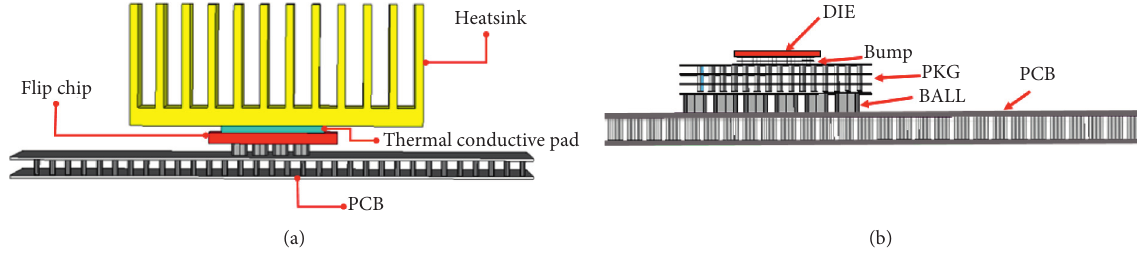
Figure 1: IC package: (a) simplified packaging model and (b) part of the packaging model without heatsink.